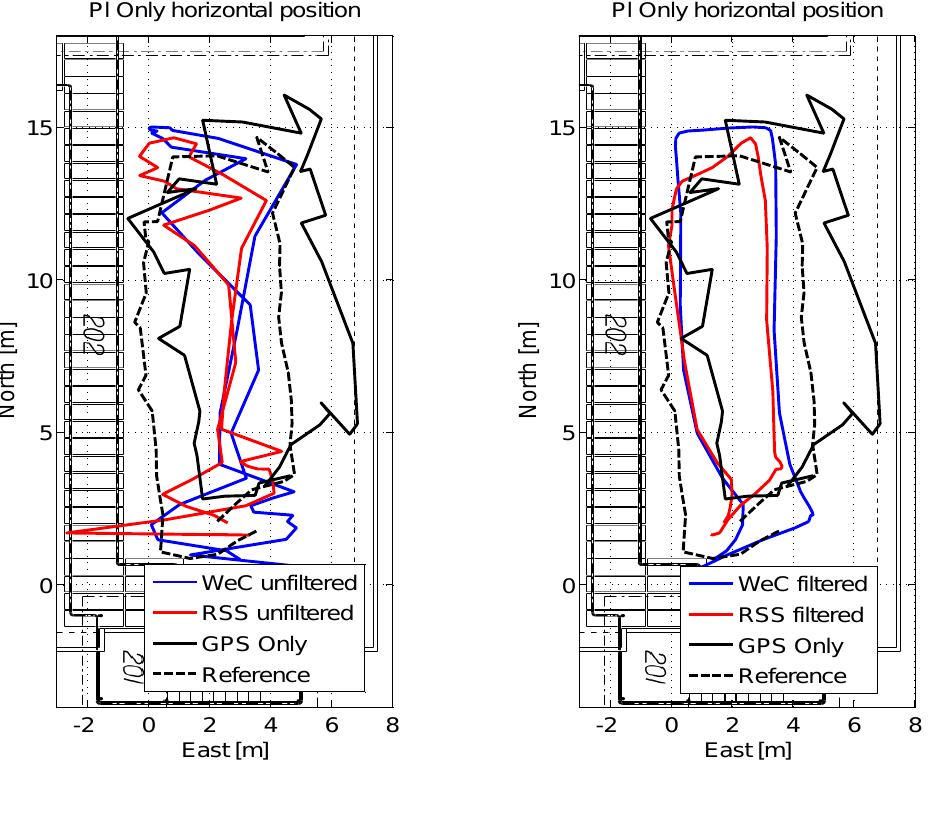
Figure 15. Pseudolite and GPS-only solutions obtained outdoors. A single lap is provided for